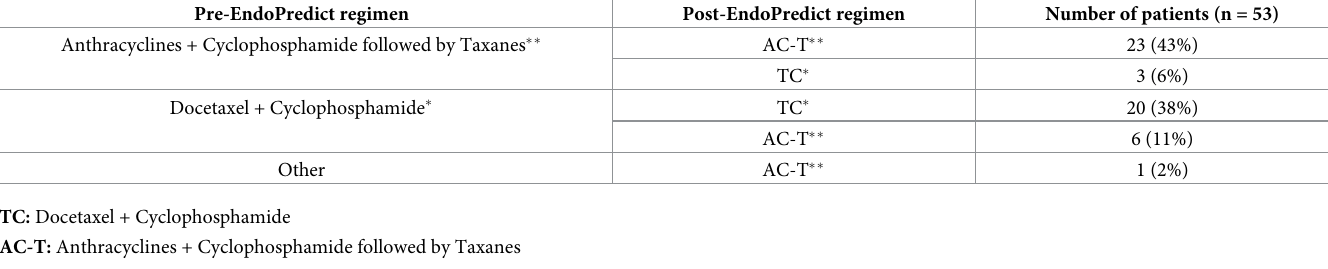
Table 5. Pre- and post-EndoPredict chemotherapy